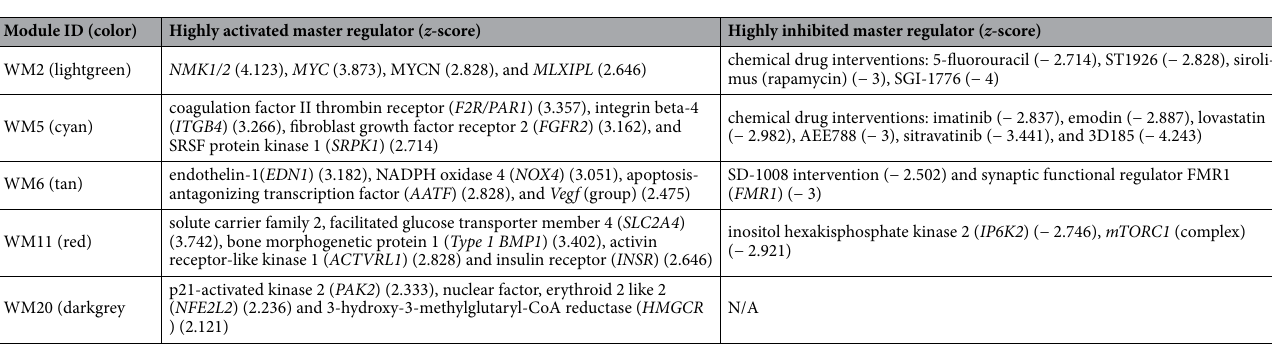
Table 2. A brief list of the top master regulators predicted to be activated or inhibited (|z-value|> 2.0) for the five WGCNA modules which are associated with the HOT lesions.